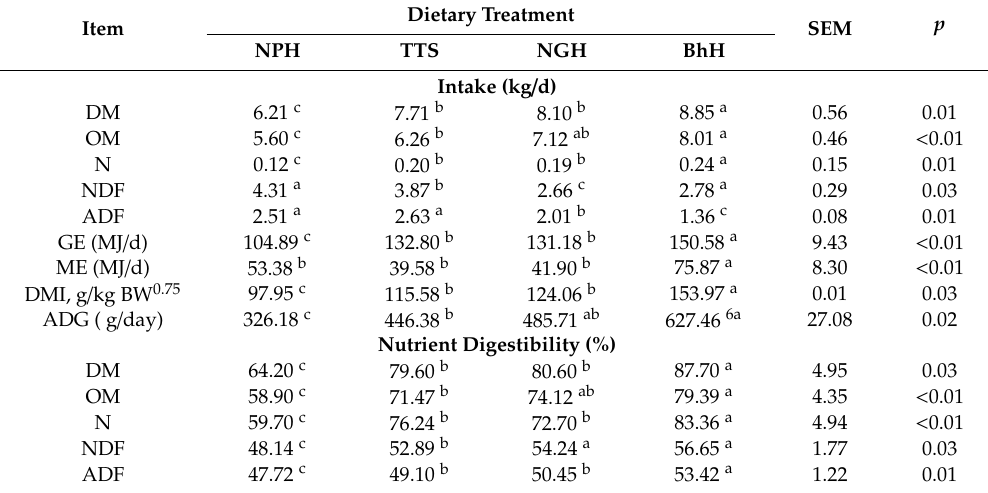
Table 2. Feed intake and nutrient digestibility of lactating dairy cows fed natural pasture hay, treated te ff straw, Napier grass hay, and Brachiaria hybrid grass hay.